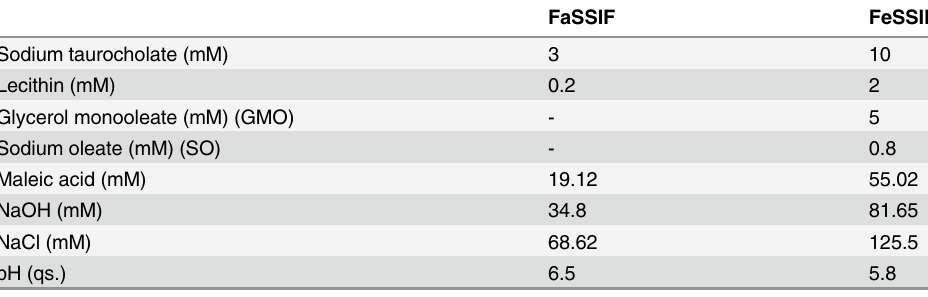
50/50 mixture. The released amount (%released) was calculated according to Eq 1.